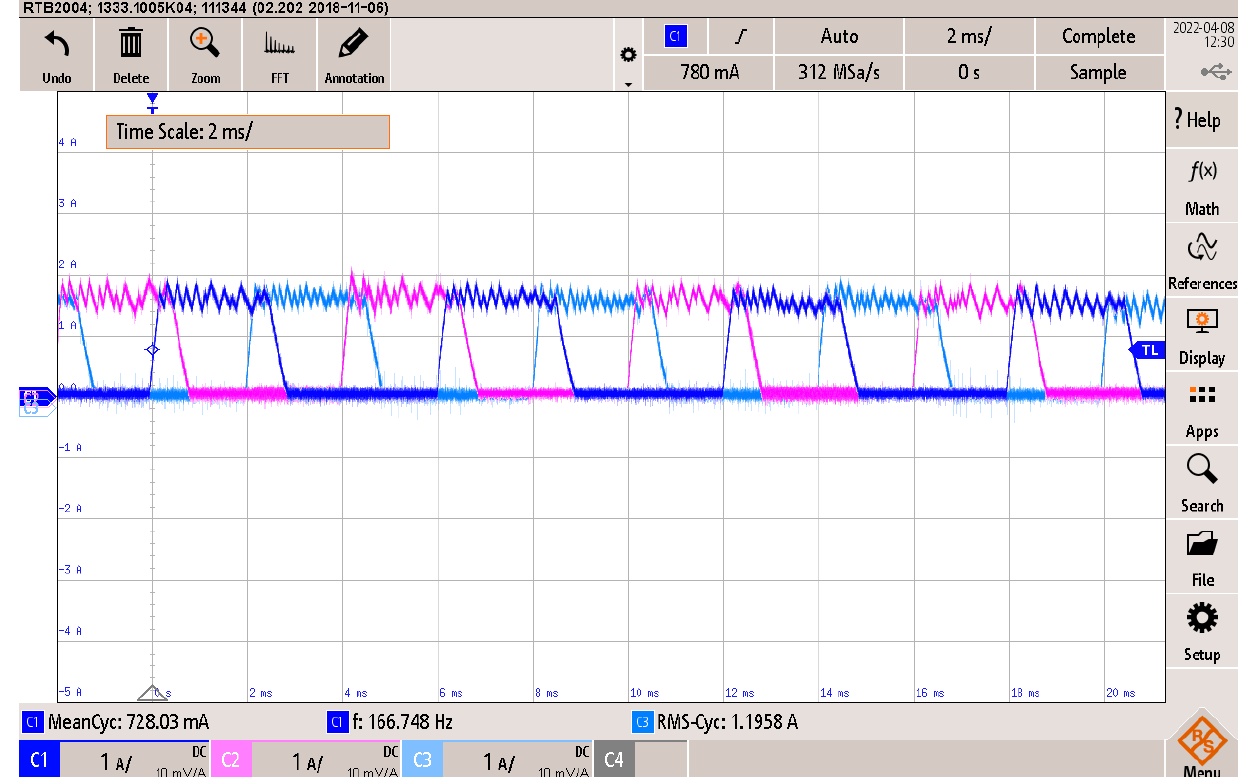
Figure 33. Phase currents of 6/10 SRM prototype in no-load operation at the speed of 1000 rpm.